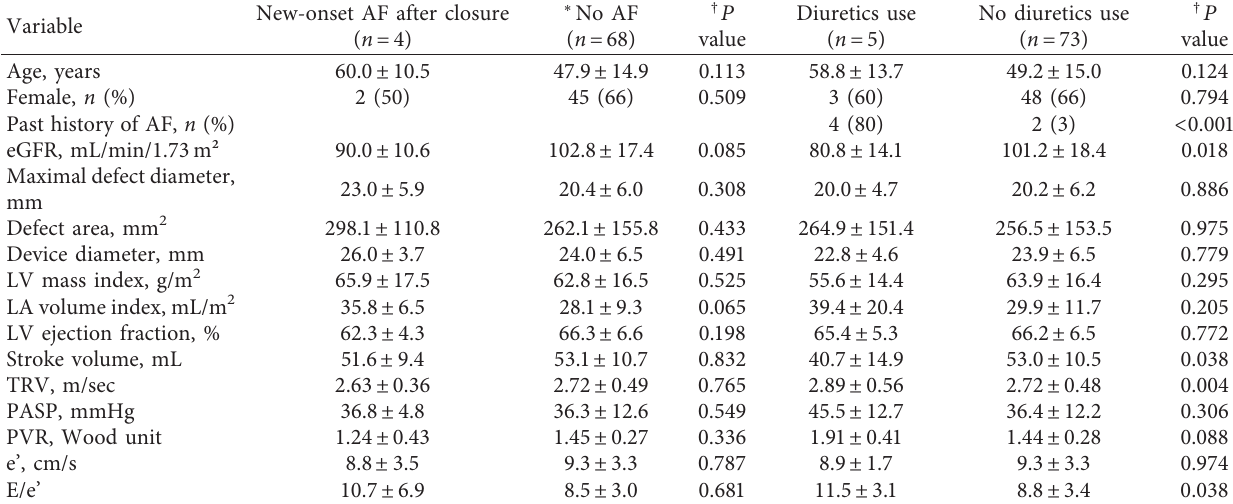
Table 2: Comparisons between groups according to new-onset atrial fibrillation after device closure and diuretics use.